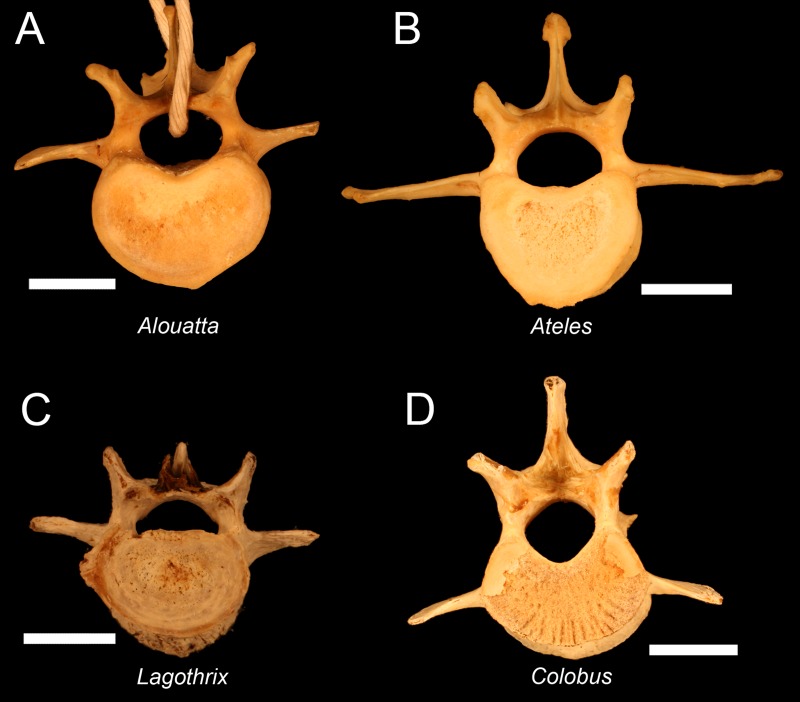
Ultimate lumbar vertebrae in atelids and an Old World monkey.Note that transverse process position in atelids shows partial invagination. (A) Howler monkey (Alouatta, CMNH 1172) L5. (B) Spider monkey (Ateles, CMNH 1237) L5. (C) Woolly monkey (Lagothrix, CMNH 5699) L4. (D) Colobus monkey (Colobus, CMNH 2144) L7. The transverse process location in atelids is similar to that in gibbons and Pierolapithecus (Moya-Sola et al., 2004). In the ‘semi-brachiating’ Colobus, the transverse processes originate from the vertebral body.